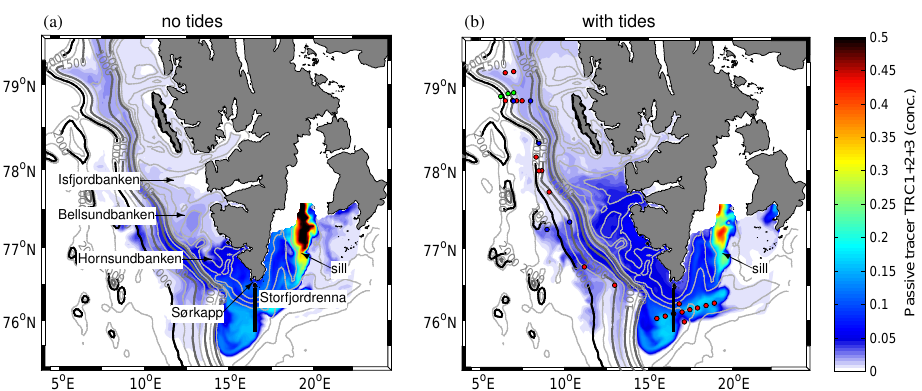
Fig. 4. Snapshot of passive tracer concentration in the bottom model level at the end (31 August) of the model run of the HIGH overflow scenario ( S sill = 35 . 8, with wind). The bold line due south from Sørkapp marks the location of the cross section in Fig. 5. Coloured dots in (b) mark CTD stations where the plume was observed in 1986 (blue dots), 1988 (green dots) and 2002 (red dots) (from Akimova et al., 2011).